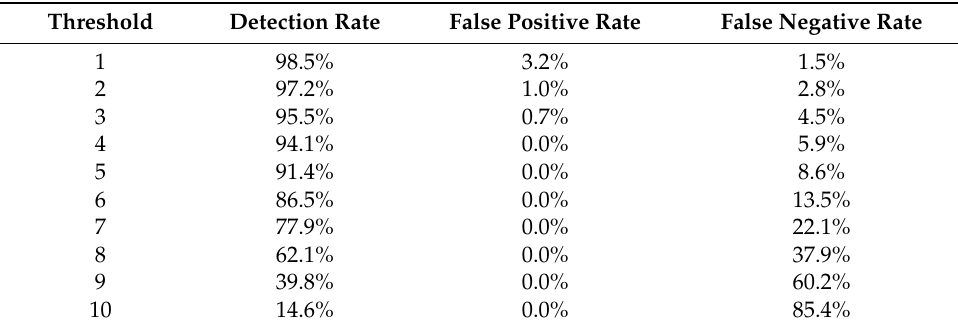
Table 4. Results of different threshold.